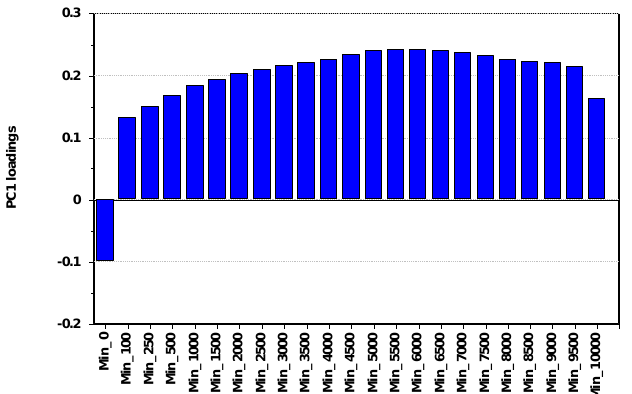
Figure 4. Loading plot displaying the correlation pattern of the 23 physical activity variables explaining 63.3% of the total variance in the variables without any adjustments for covariates. The variable names imply the lowest intensity levels in each intensity interval defined in Section 2.3.